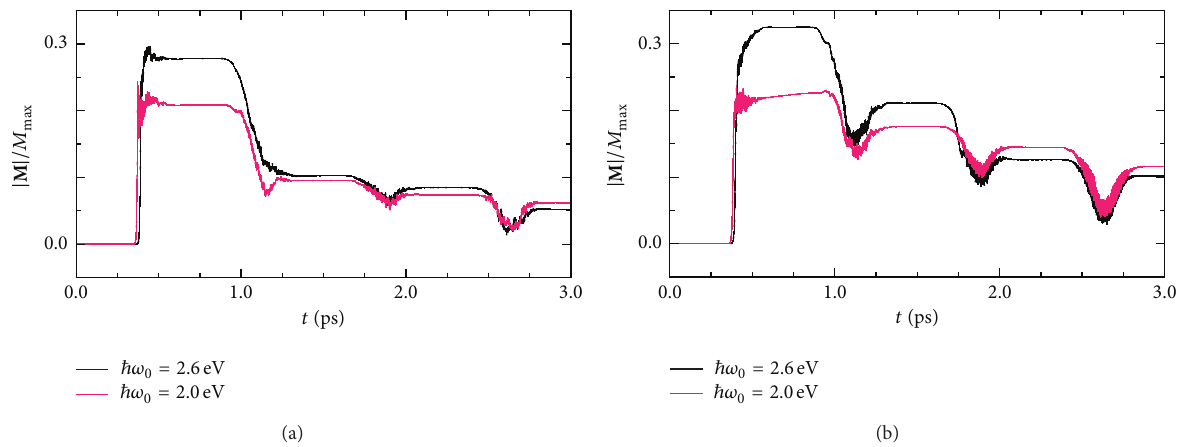
Figure 7: Manipulation of the magnetization by applying successive pump laser pulses in the form of (15) with (a) A 0 ‖ a and (b) A 0 ‖ c , where the photon energy ℎ𝜔 0 is set equal either to 2.0 eV or to 2.6